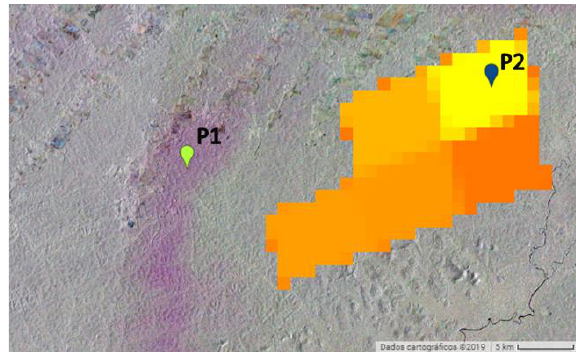
Figure 7: Sentinel-1 backscatter decay linked to super-storm cells in Roraima state (Brazil). The approximate size of the super-cell (in yellow) is 5x5